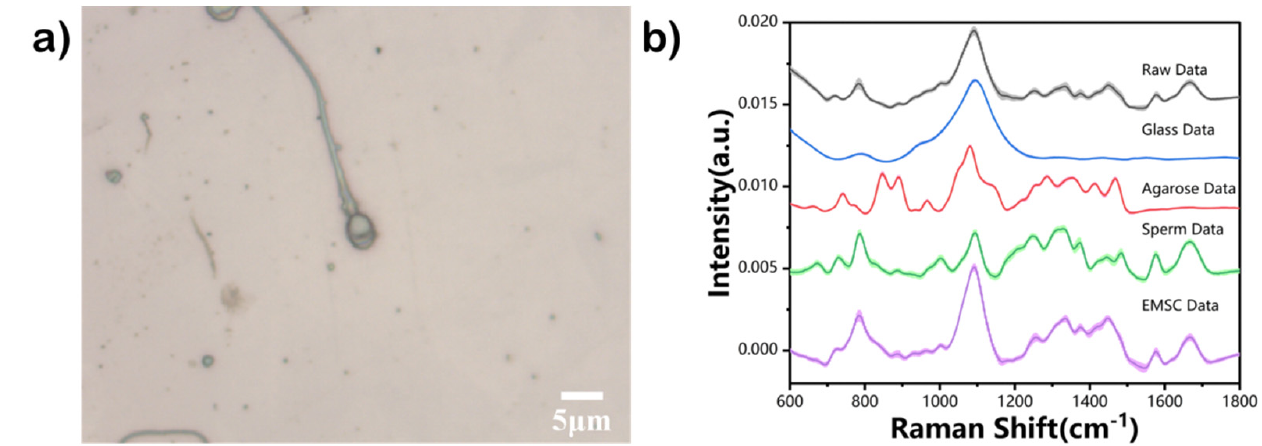
Figure 1. ( a ) Bright-field image of sperm cells on the glass substrate, scale bar = 5 μ m; ( b ) The raw Raman spectra of sperm cells (black) obtained from glass slides, Raman spectra of sperm cells (green), and agarose (red) measured on a metal substrate, Raman spectrum of glass slides (blue), and the final background-corrected spectra (purple) obtained by using EMSC algorithm.